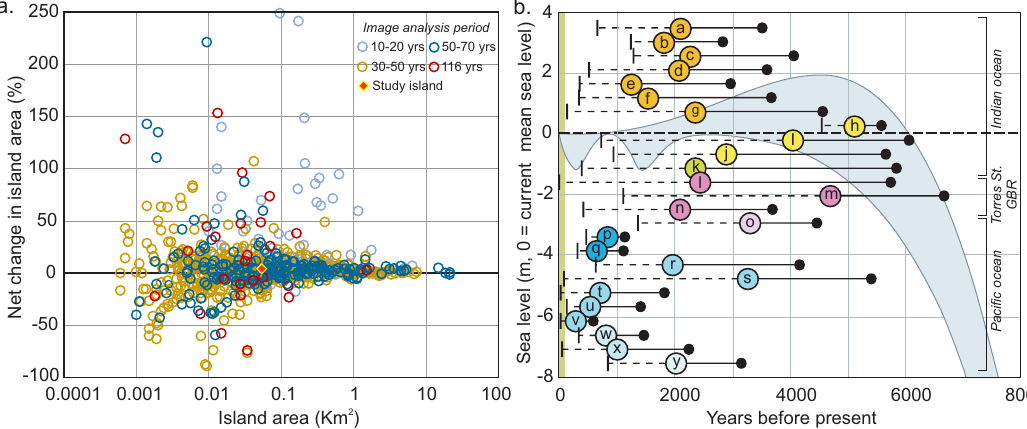
Fig. 1 | Summary ofatoll reefisland studies. a Planform changes in island areaof 1108islandsinthePaci fi candIndianOceanshowingthenetchangeinislandareaat different timescales of analysisover the past century.Data source 37 . b Summary of reef island evolution studies highlighting the onset and period of island accumu- lation in the mid-to-late Holocene. Blue-shaded area de fi nes the envelope of sea- level behaviour in the Indo-Paci fi c. The solid black circle denotes the earliest radiometricage,thecoloured circledenotesthemean radiometricage of samples, vertical line denotes the latest radiometric age. Different coloured circles re fl ect